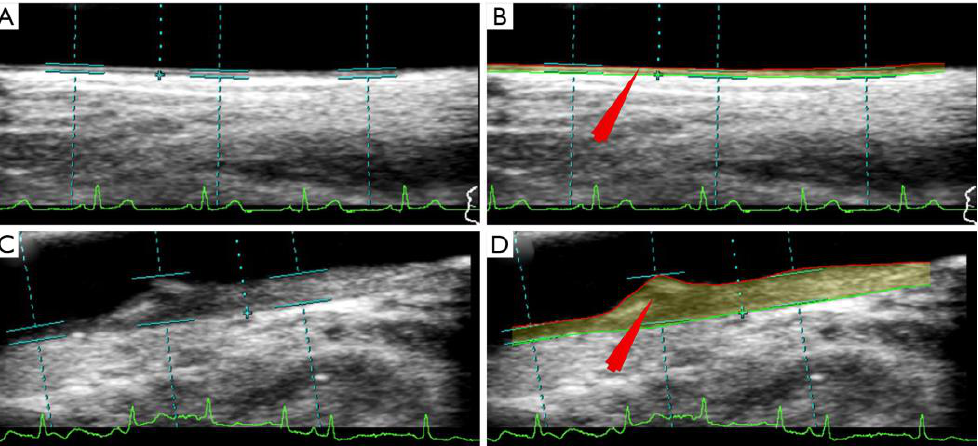
Figure 6. CVD risk stratification is based on an automated AtheroRisk-ML Integrated system. Row 1 ( A , B ) is low risk, and Row 2 ( C , D ) is High Risk [137].